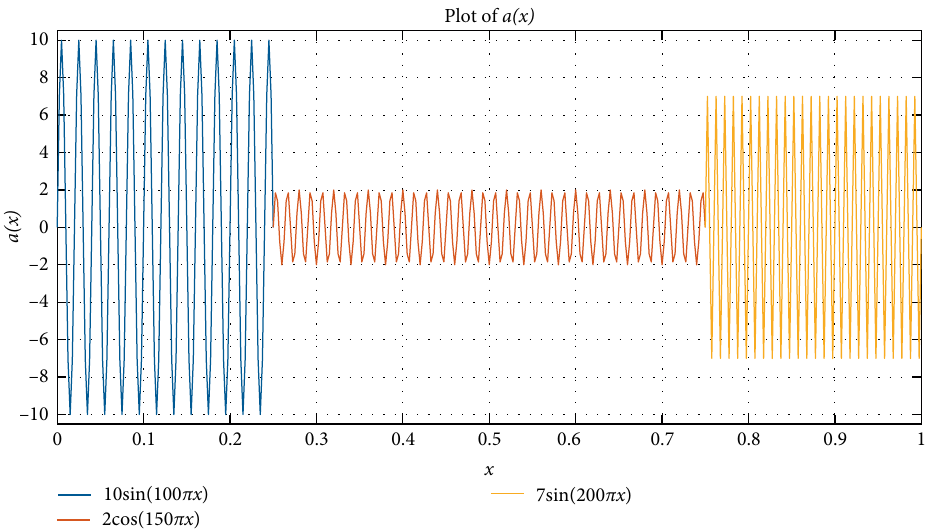
Figure 4: Diffusion parameter